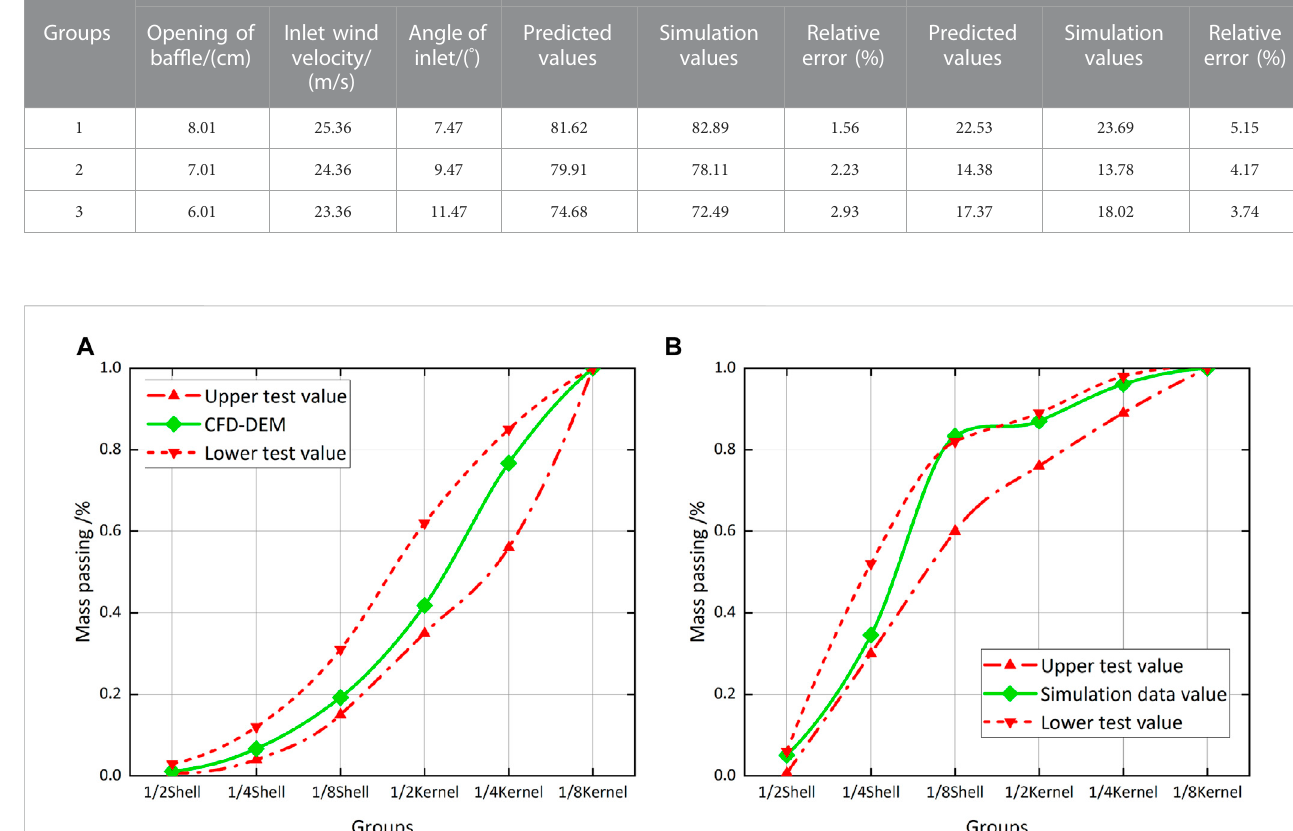
FIGURE 10 Simulation status and proportion chart. (A) Each material quality at the kernel outlet passes through (B) Each material quality at the shell outlet passes